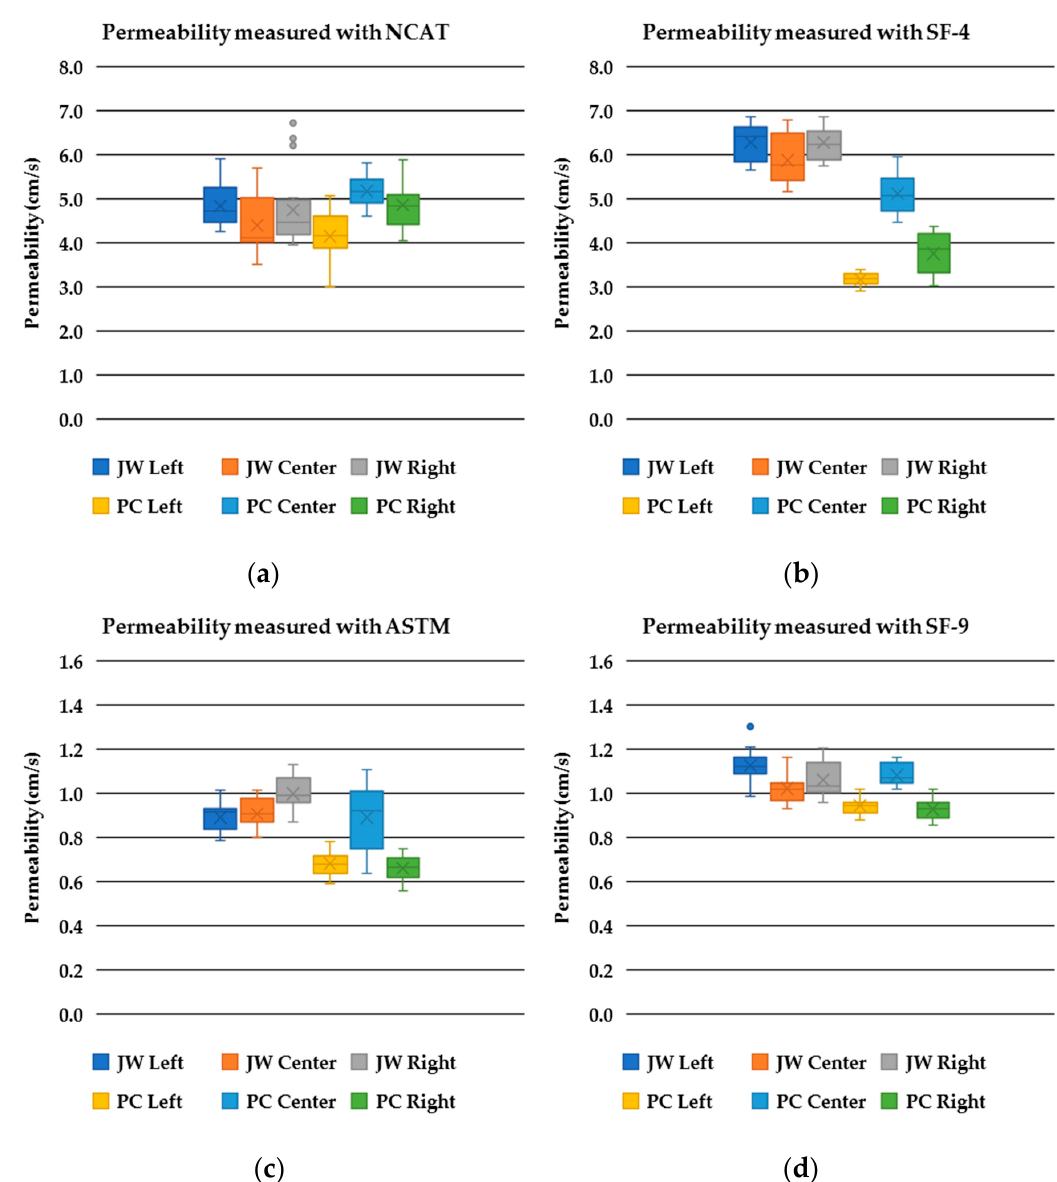
Figure 9. Descriptive statistics with the aid of box-and-whisker diagrams of the permeability measured with ( A ) NCAT (falling head), ( B ) SF-4 (falling head), ( C ) ASTM (constant head), and ( D ) SF-9 (constant head). Note the y -axis values for ( A ) and ( B ) range from 0–8 cm/s, while the values for ( C ) and ( D ) range from 0–1.6 cm/s.